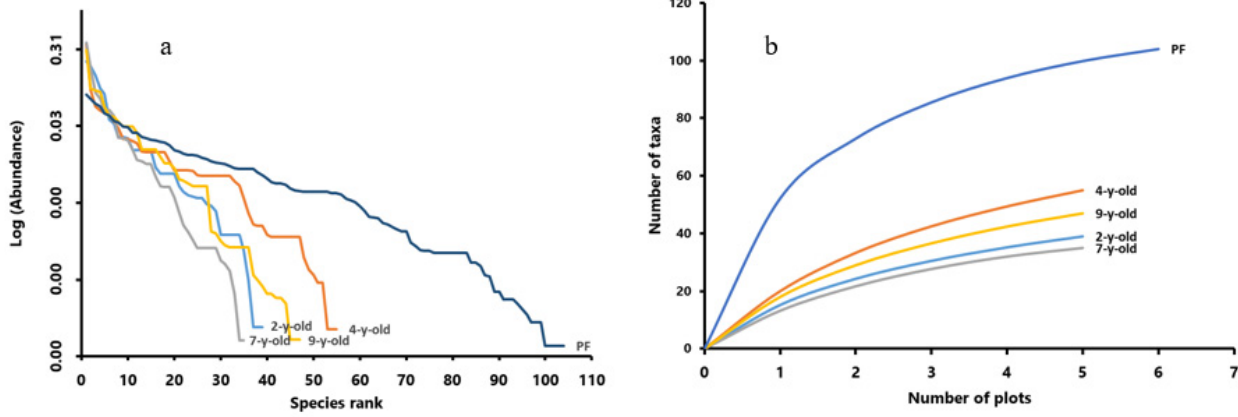
Figure 3. ( a ) The rank abundance curve or Whittaker plot implemented by plotting the log-transformed species abundance against species rank for all vegetation lifeforms. ( b ) Species accumulation curve for all vegetation lifeforms using sample rarefaction (Mao’s tau) in fallow forests between two- and nine-years-old and primary forest (PF) in coastal areas of north Manokwari, West Papua, Indonesia.